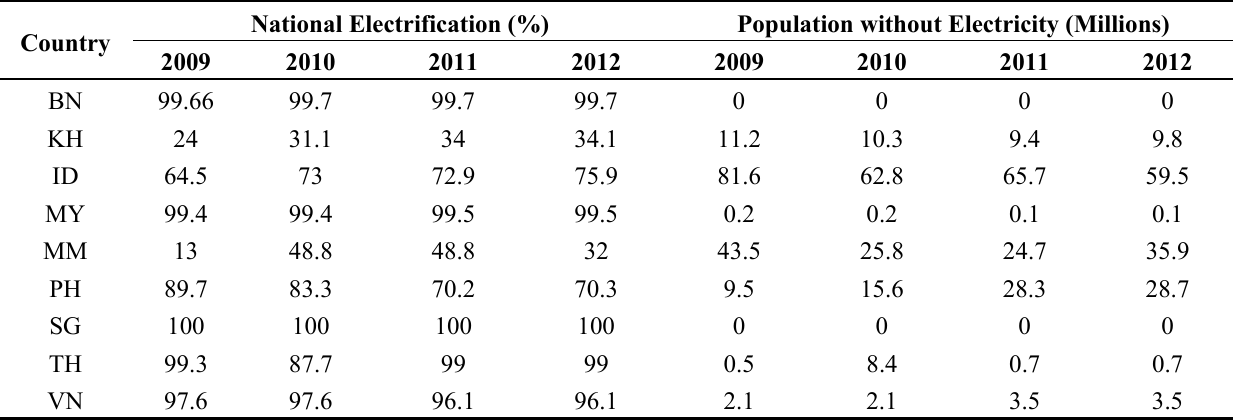
Table 2. ASEAN electricity access between 2009–2012. National Electrification (%) Population without Electricity Country